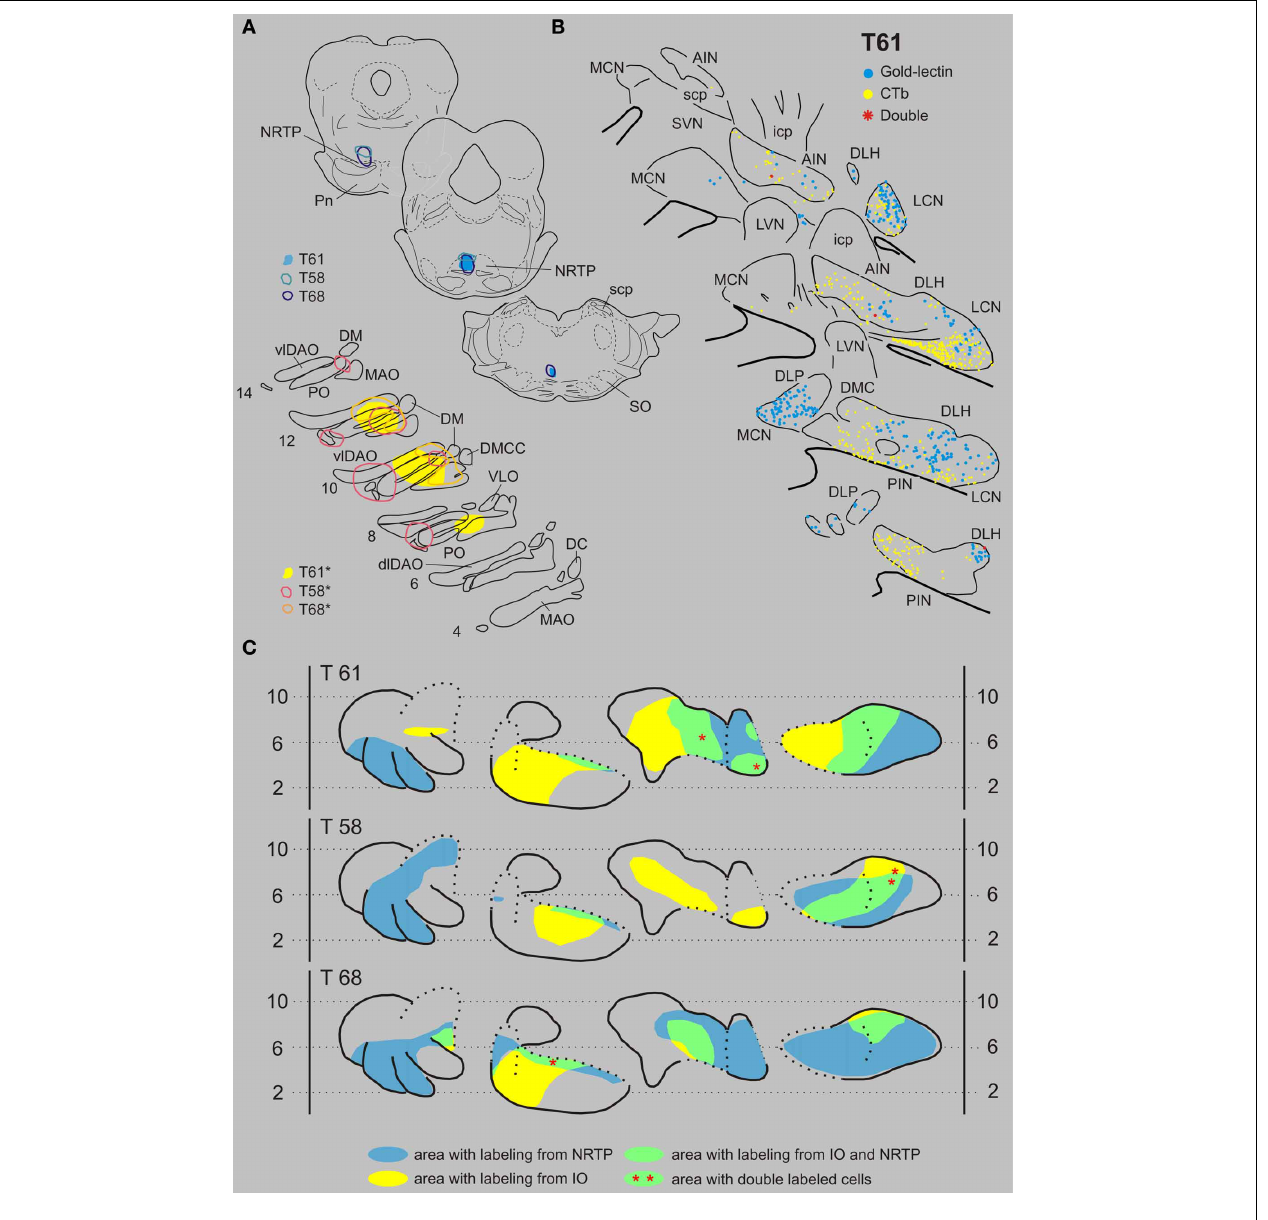
FIGURE 5 | Diagrams depicting results of the combination IO and the NRTP. (A) Injection sites of all three analyzed cases. Upper left hand panels show the injection sites within transverse diagrams of the pontine region. Bottom panels show the related injections sites in the IO. CTb injections (case number indicated with ∗ ) were made in the IO of all three cases. (B) Plots of 5 equidistant (320 micron) sections showing labeled neurons within the contralateral CN of case T61. (C) Overview of the distribution of